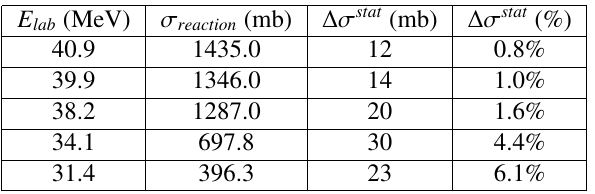
Table 1: Summary of the reaction cross-sections for 8 Li + 209 Bi. The parameters of the real Woods-Saxon potential were fixed at V 0 = 113 MeV, r 0 = 1.122 fm and a = 0.63 fm during the fitting procedure which reproduce the average fusion barrier 29.39 MeV in the centre-of-mass frame.